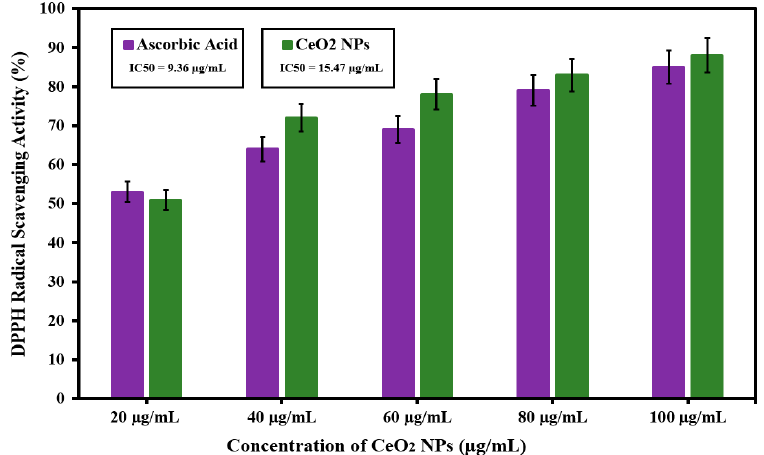
Figure 4. DPPH radical scavenging action of CeO 2 nanoparticles and ascorbic